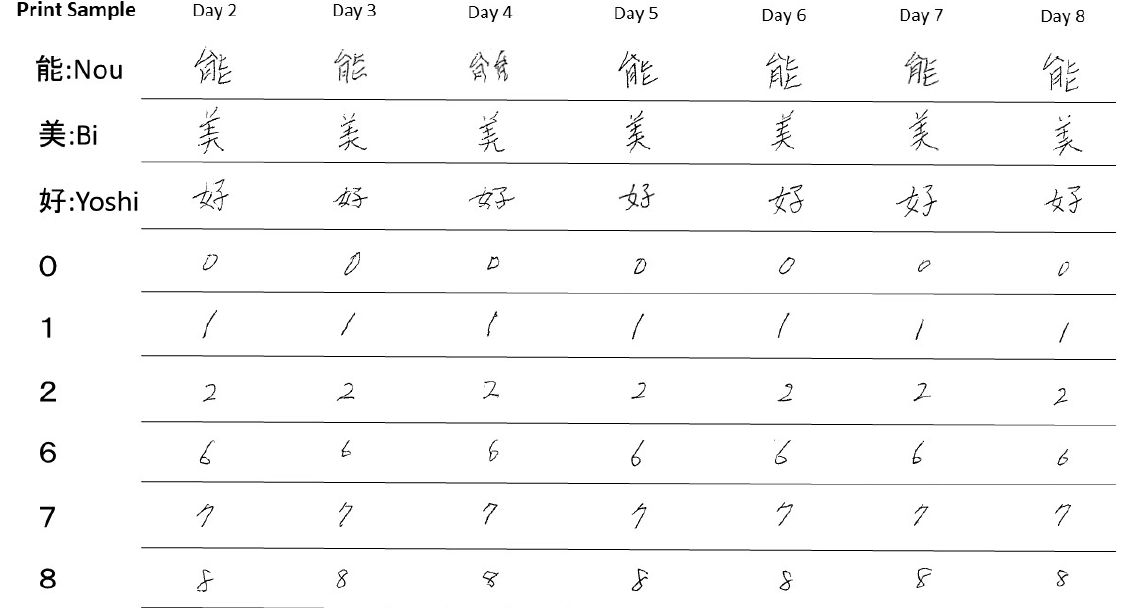
Figure 1. Characteristic changes in the patient’s written characters (partially extracted). It was easier to identify changes in Kanji characters than those in numbers. One Japanese character has multiple meanings. For example, “Nou” is the power to do work, work, action, effect, efficacy, working, technique, place name, etc. The character for “Bi” means fine or beautiful in appearance, excellent or good in content, or praiseworthy. The character for “Yoshi” means loving, preferring, beautiful, good looking, good, just right. Combinations of several letters indicate a particular meaning. For example, combining “Bi” with “Kei”, meaning “shape” means especially good